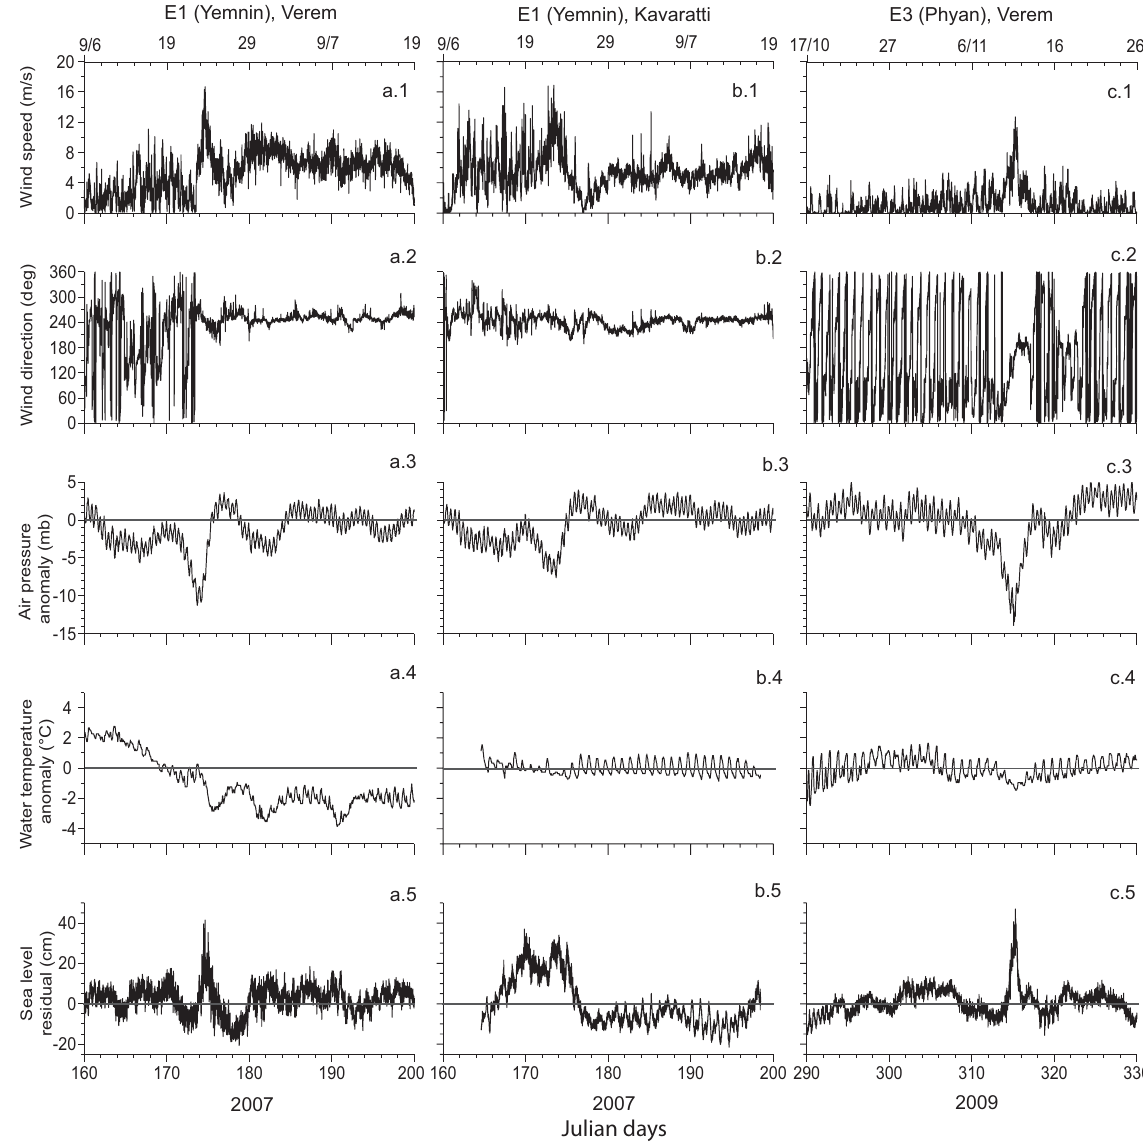
Fig. 2. Sea level and surface meteorological parameters at Goa during the episodic events. ( a 1–5) wind speed, wind direction, atmospheric pressure anomaly, water temperature anomaly and sea-level residual during the atmospheric disturbance event E1 in June 2007 (named Yemnin ) at Verem. ( b 1–5) Variables same as in (a) at Kavaratti Island region during E1, and ( c 1–5) Variables same as in (a) during the atmospheric disturbance E3 (named Phyan ) in November 2009 at